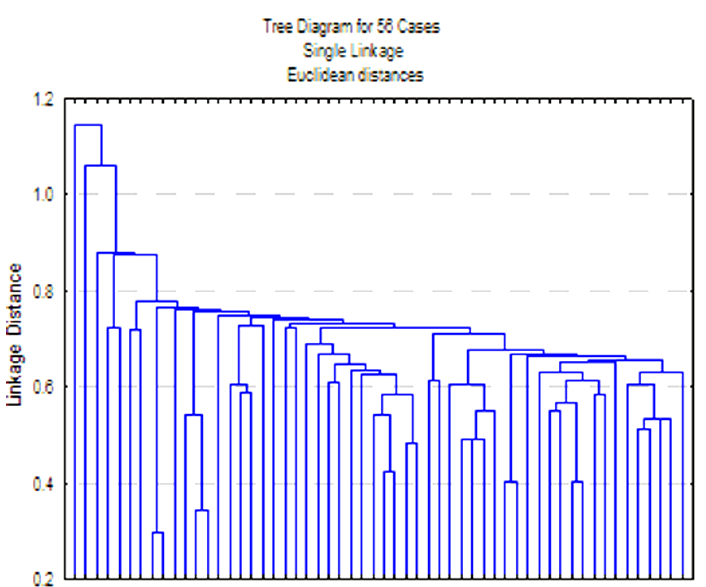
Figure 1. Tree of the hierarchical structure of the distribution of drivers of combating crimes against human life and health